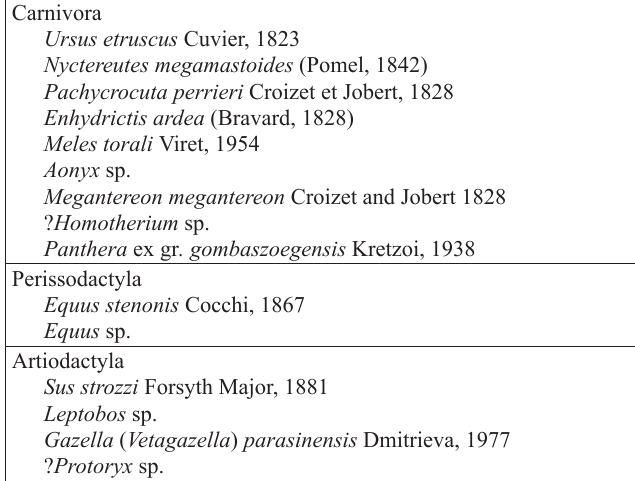
Table 8. Composite faunal list of Palantokan. Besides the listed taxa numerous fragments of deer antlers, turtle shells, and ostrich egg-shells are also mentioned in literature. The list is based on Lebedeva 1972, 1974, 1978; Sablin 1990; Kuzmina and Sablin 1991; Sotnikova and Sablin